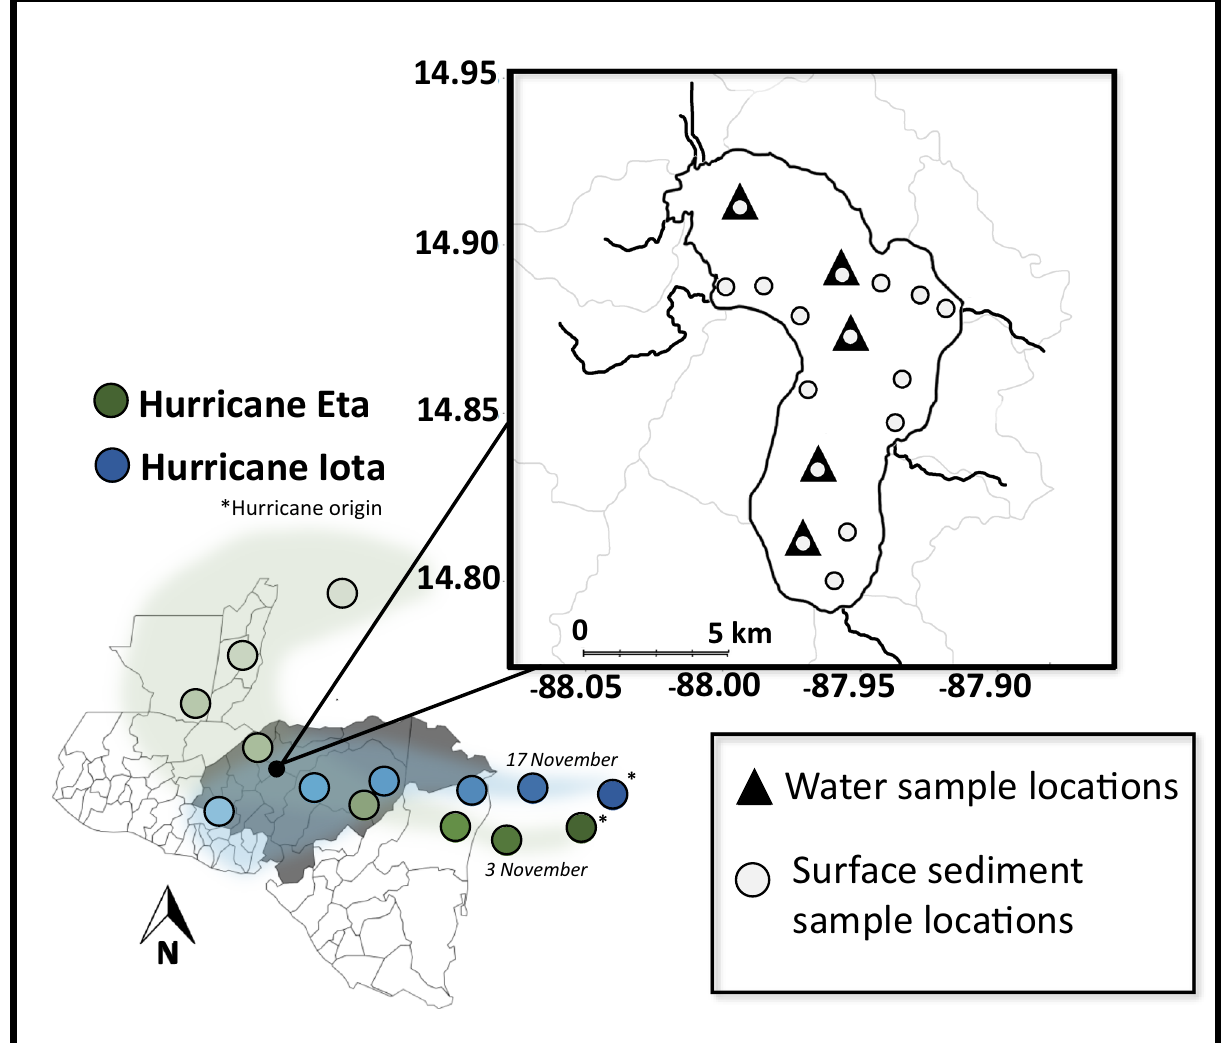
Figure 1. Sampling locations (water column and surface sediments) in Lake Yojoa and approximate paths of Hurricanes Eta and Iota. Color gradation (dark to light) denotes direction of the cyclones. Map